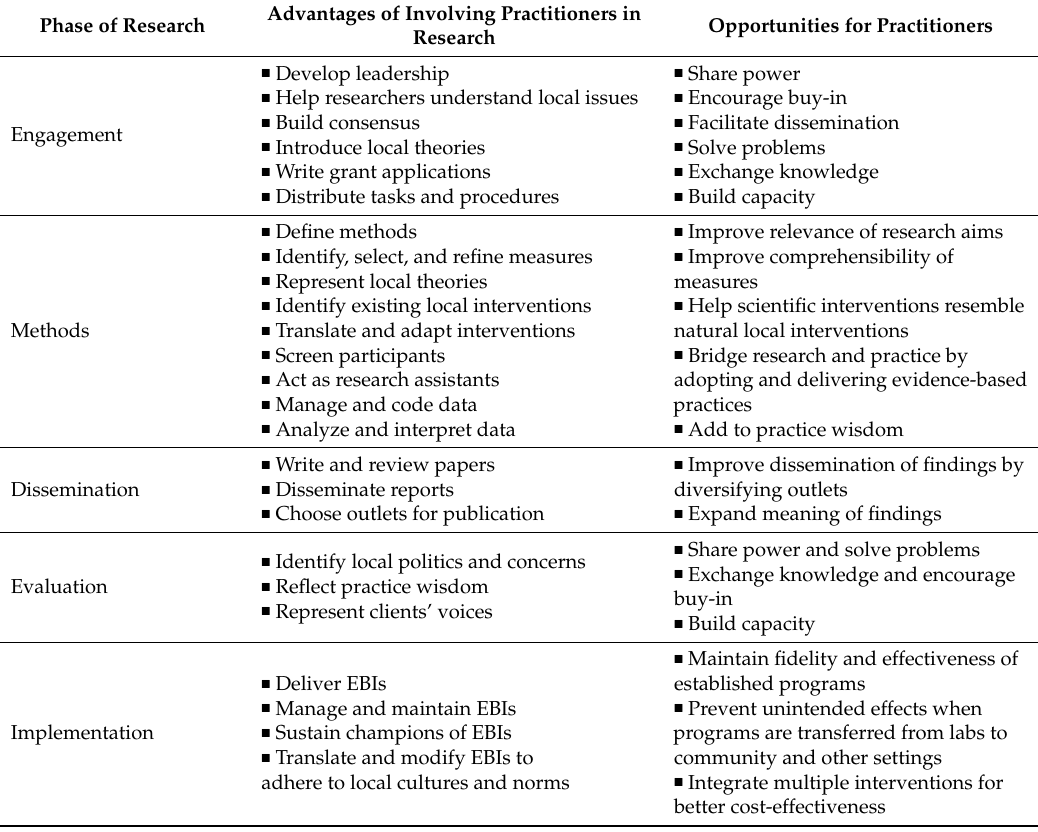
Table 1. Advantages and opportunities for practitioner–researcher